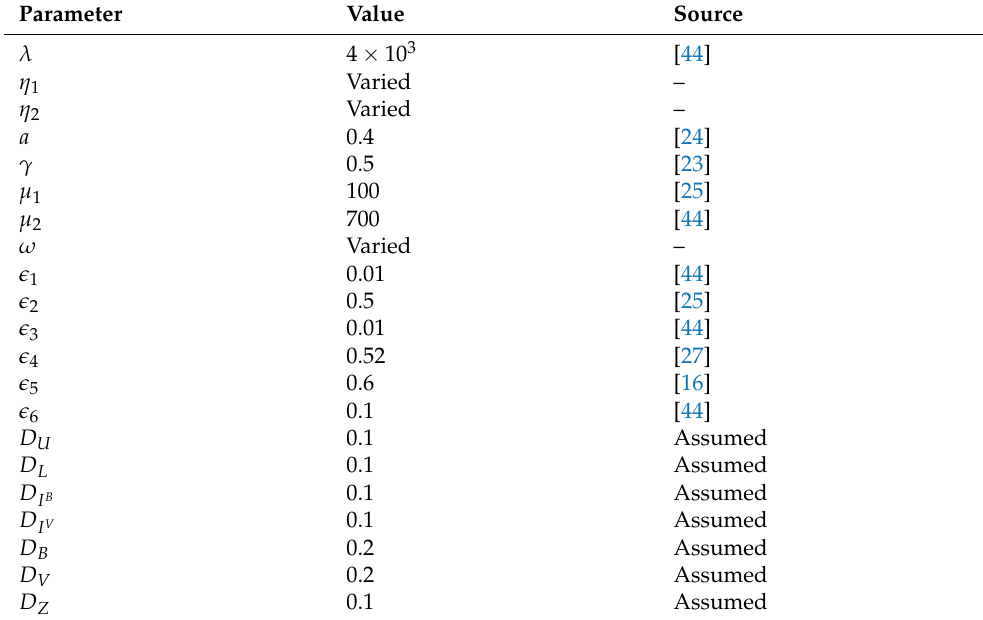
Table 1. Parameters’ values of system